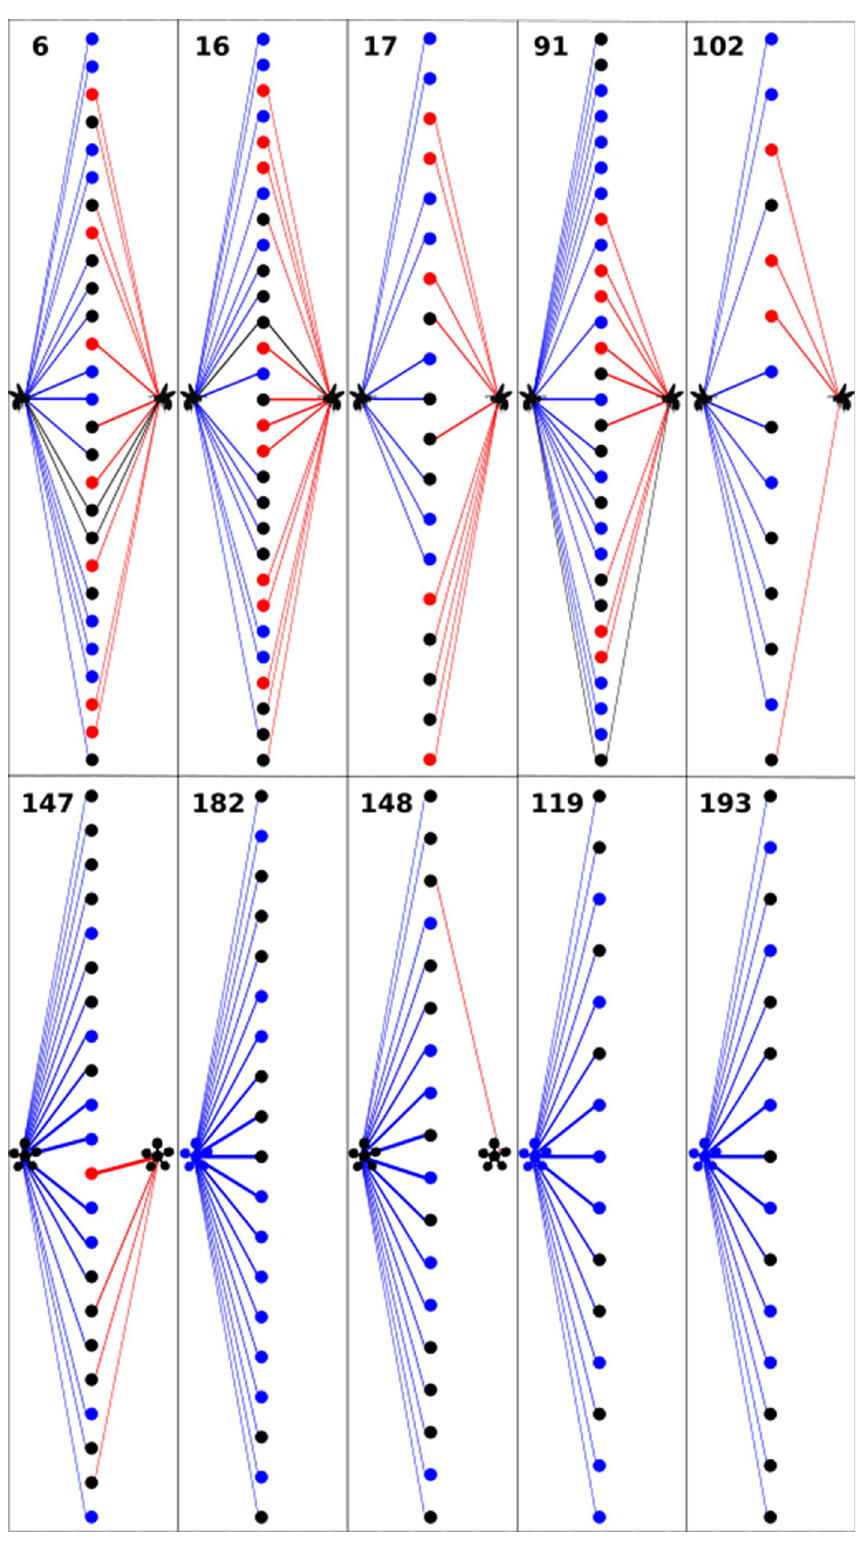
Fig 3. Temporal turnover in the number of interaction partners for pollinators (upper panels) and plants (lower panels) in the studied Cerrado community. Turnover is shown for the five species with the largest number of